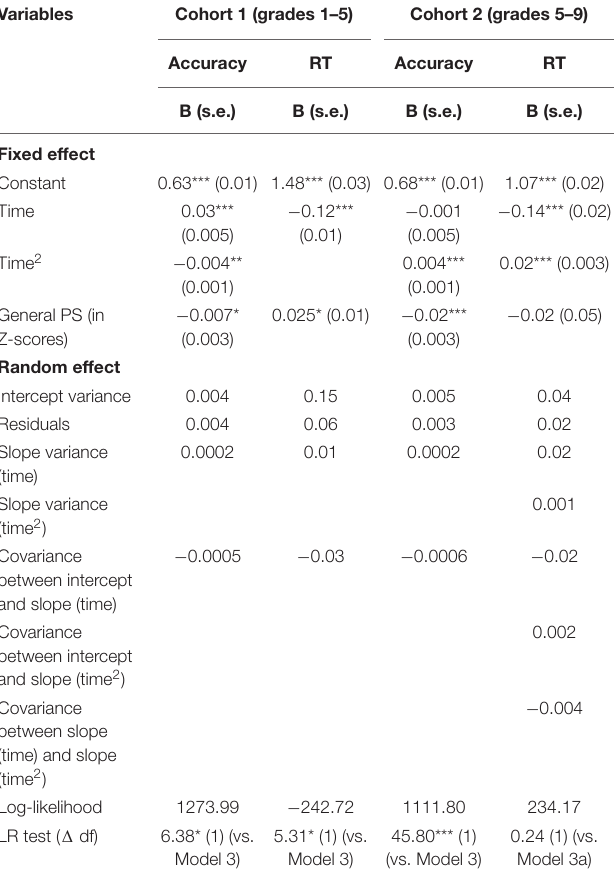
TABLE 12 | Results of ME growth models for changes in ANS accuracy and RT with general PS (in sec.) as a